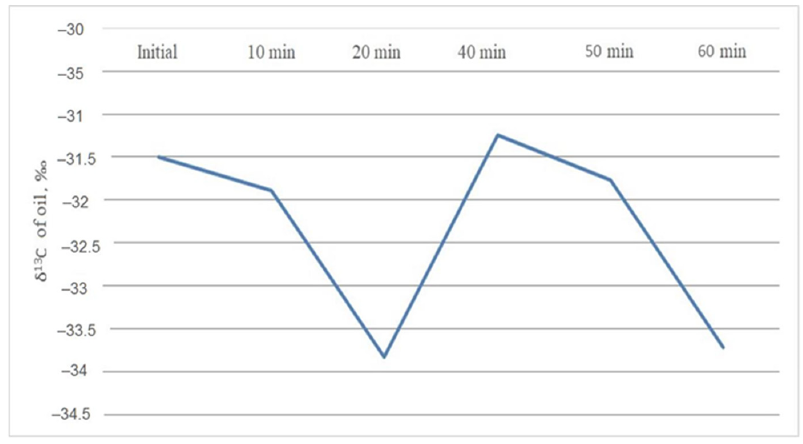
Figure 6. A time course of δ 13 C in samples exposed to an electromagnetic field.